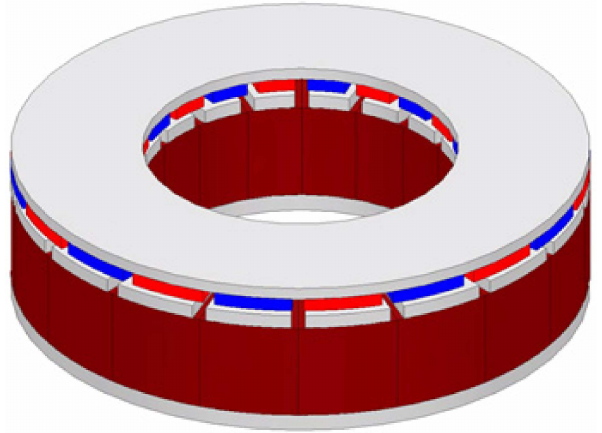
Figure 6. Axial flux permanent magnet synchronous motor